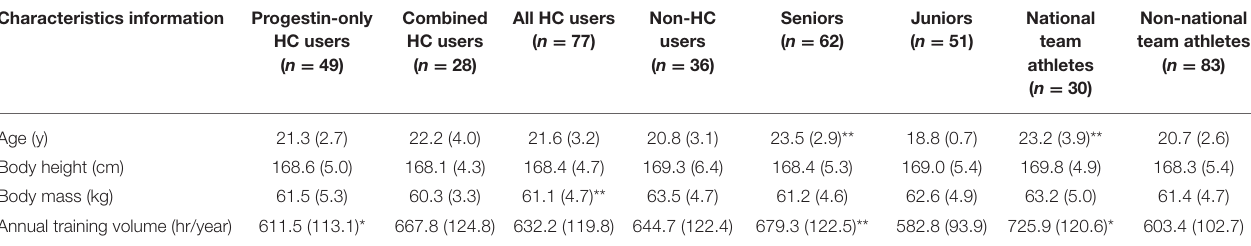
TABLE 1 | Participant characteristics stratified by type of hormonal contraceptive (HC), and by use and non-use of HC (mean and SD). Characteristics